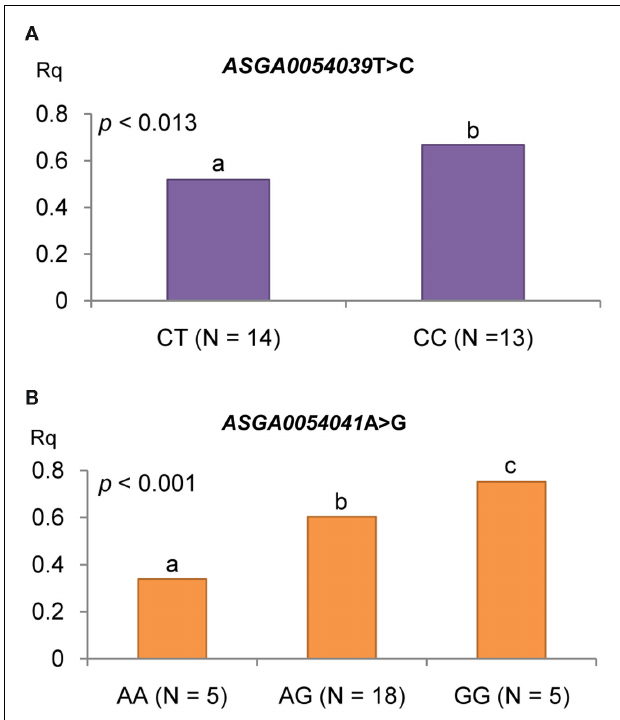
FIGURE 6 | Phosphatidylcholine transfer protein gene expression using RT-qPCR conditional on the genotypes of PCTP SNPs (ASGA0054039 T > C,ASGA0054041A > G). PCTP gene expression conditional on genotypes of (A) ASGA 0054039T > C and (B) ASGA 0054041 A >